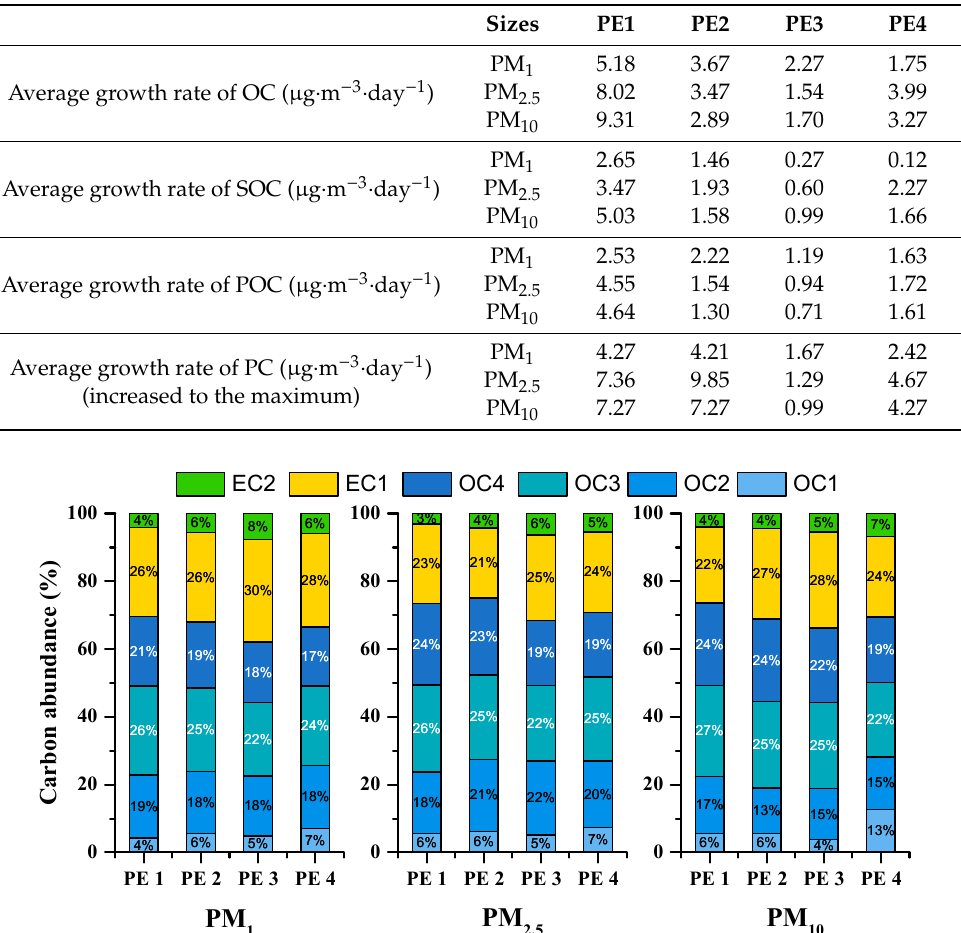
Figure 4. The percentage contributions (to TC) of eight carbon fractions in PM 1 , PM 2.5 and PM 10 when PM 2.5 exceeded 100 µ g · m − 3 during the pollution formation of the four PEs.